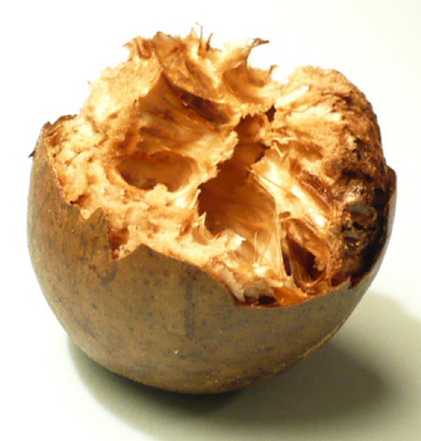
Fig. 6: Siraitia grosvenorii fruit cut open (image by David Badagnani, https://commons.wikimedia.org/wiki/File:Luohanguo-open.jpg, CC BY 3.0)